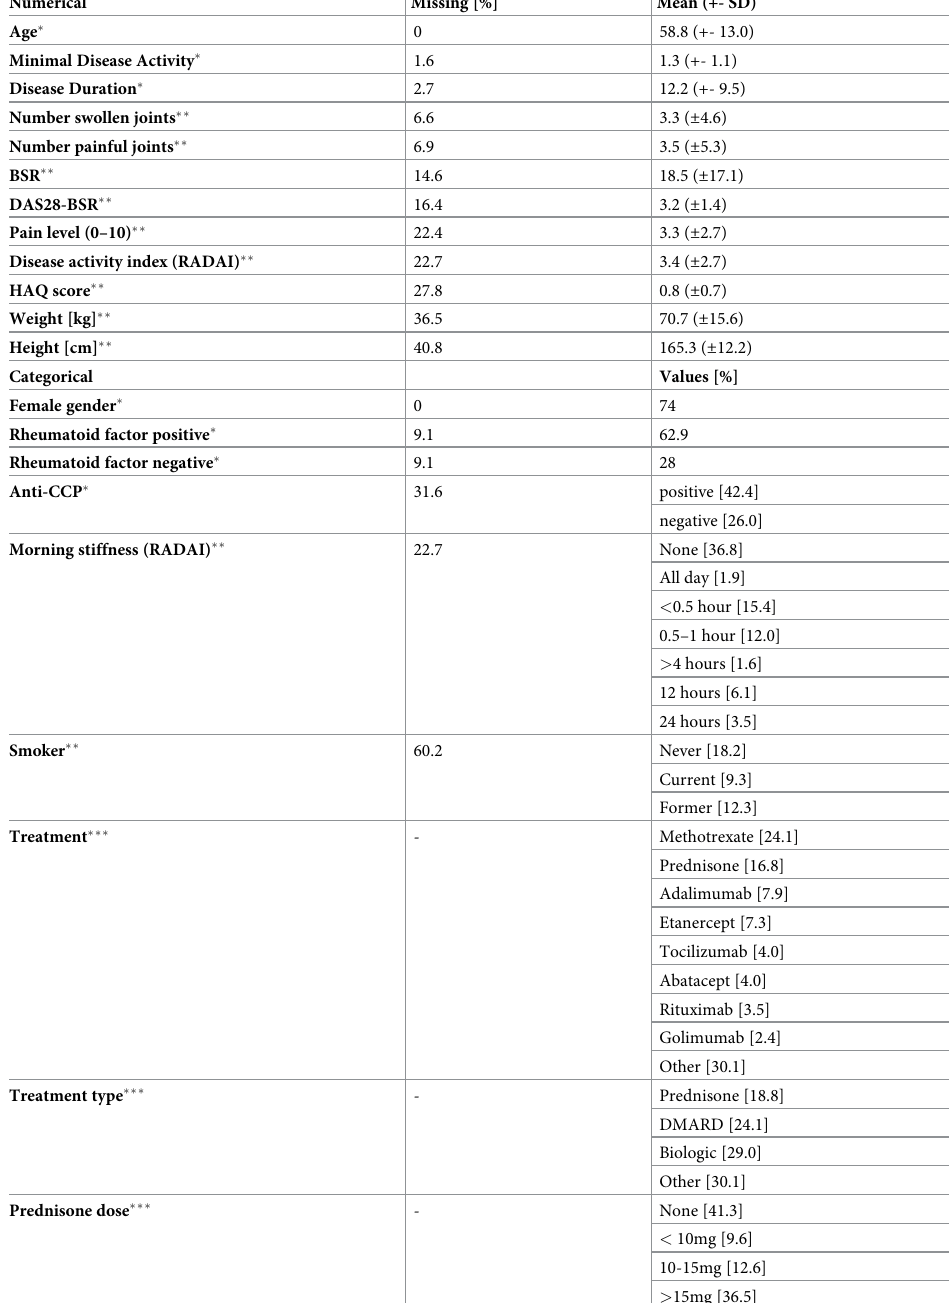
Table 1. Clinical characteristics and input